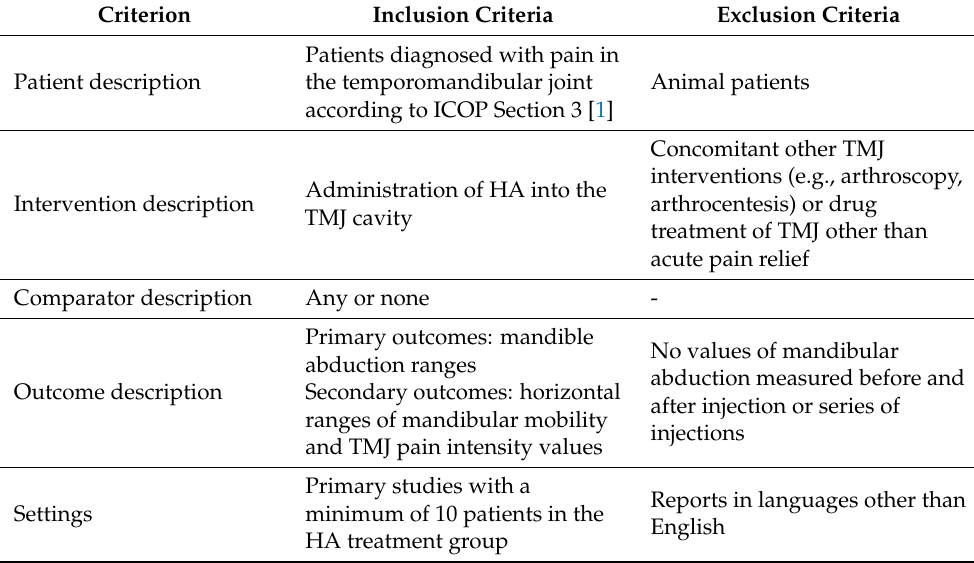
Table 1. Criteria for including studies in the systematic